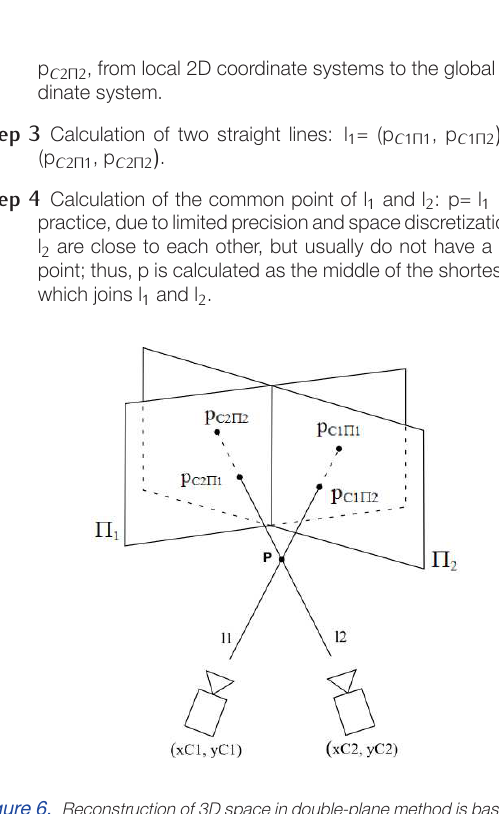
Figure 8. Location of control points in our calibration pattern allows to define the third, virtual plane , indicated by three dashed lines. Π 3 Algorithm 2. Improved method for 3D coordinates